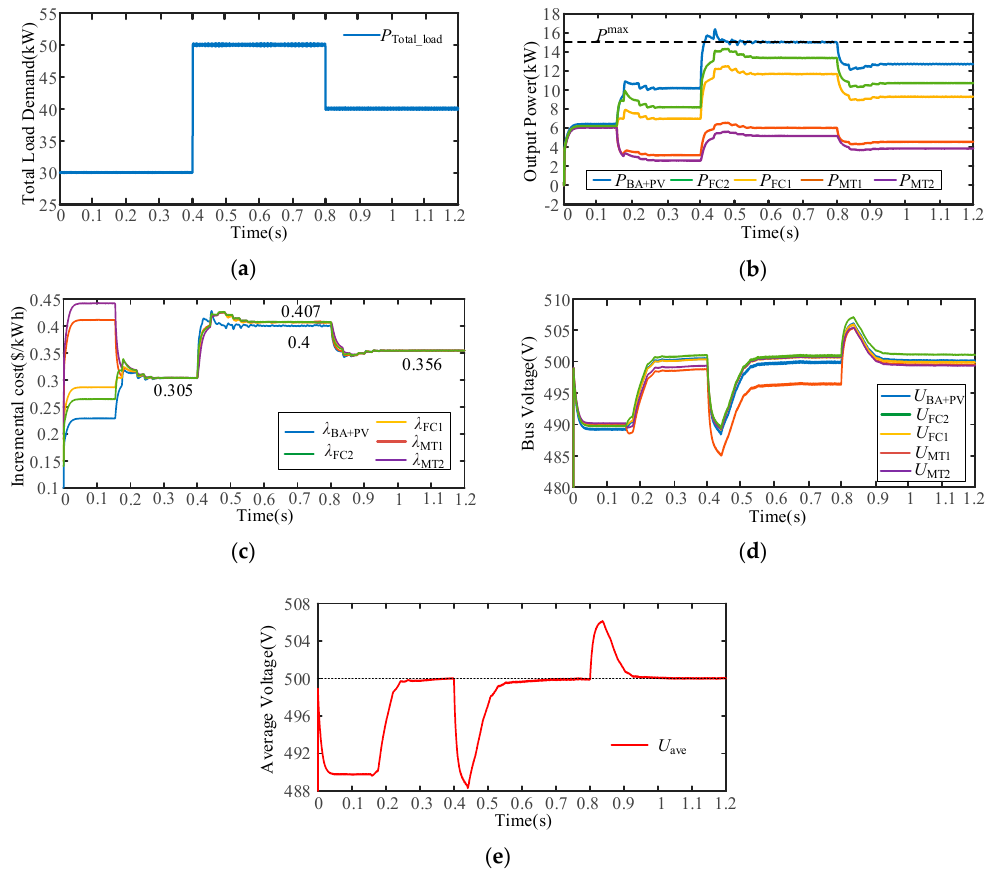
Figure 12. Effect of the proposed scheme considering power limitation. ( a ) the total load demand; ( b ) the output power of each generator; ( c ) the incremental cost of each generator; ( d ) the bus voltages; ( e ) the average voltage of the system.